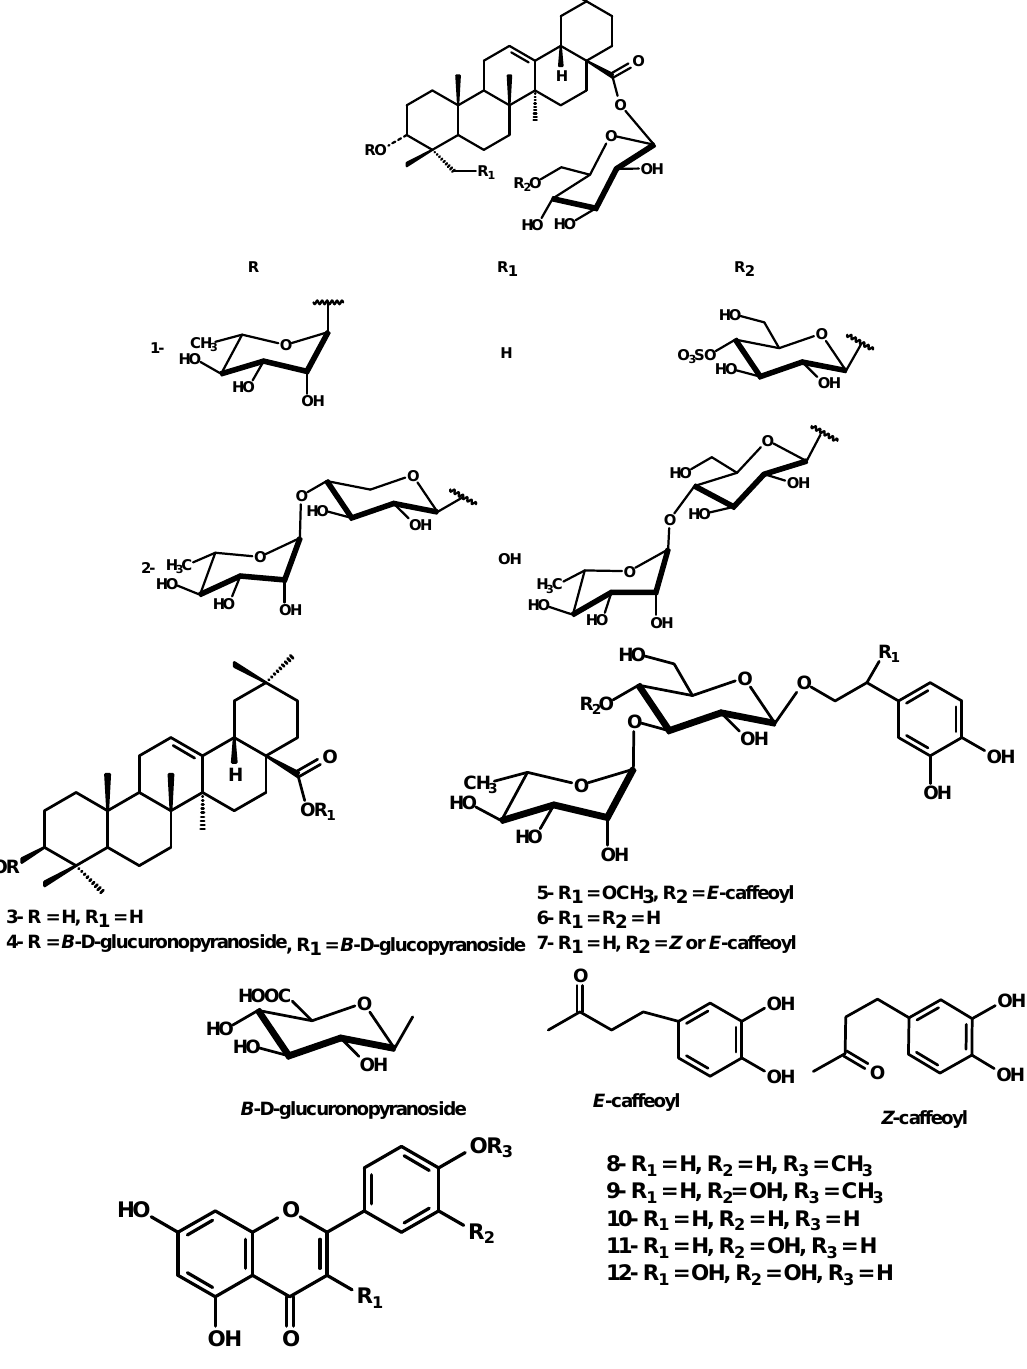
Figure 1. Structure of isolated compounds from the leaves of Duranta